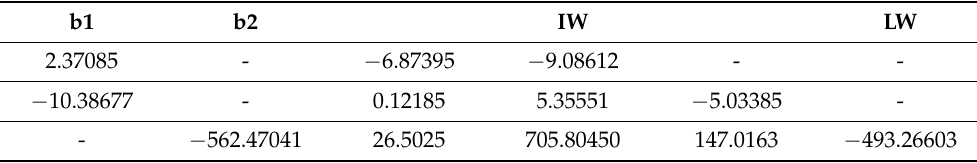
Table 6. Weights and biases of the best-trained ANN gearbox efficiency prediction model.